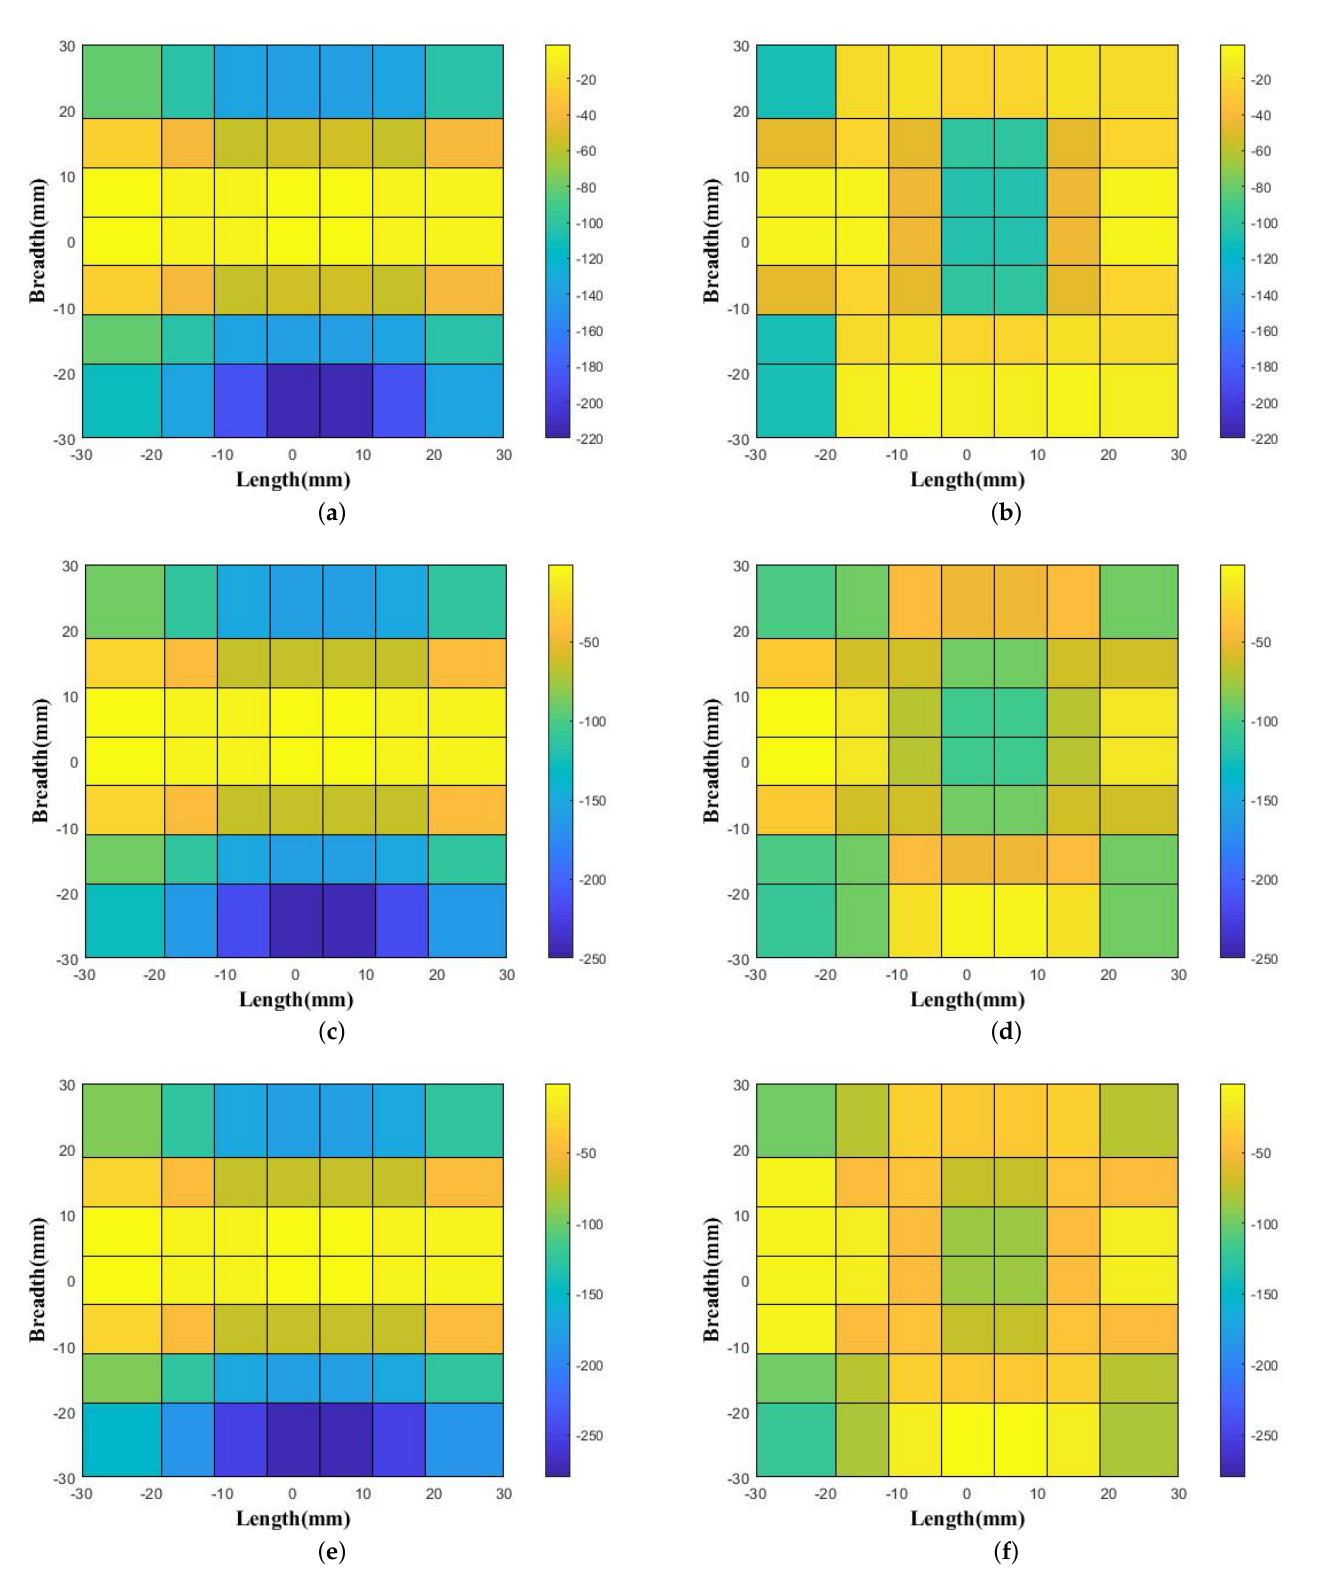
Figure 6. Obtained phase distribution noted above the feed WR-75 waveguide without the proposed prototype ( a ) at 10 GHz, ( c ) at 11 GHz, and ( e ) at 12 GHz and with the placement of the proposed prototype ( b ) at 10 GHz, ( d ) at 11 GHz, and ( f ) at 12